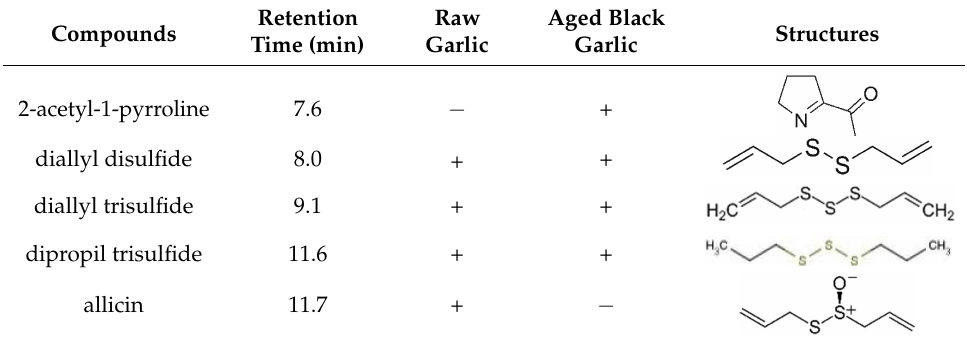
Figure 1. Representative chromatograms of raw garlic ( upper panel ) and black garlic ( lower panel ) Headspace-SPME technique was used to obtained samples followed by GC-MS analysis. Table 1. Main compounds of raw and black garlic in the gas